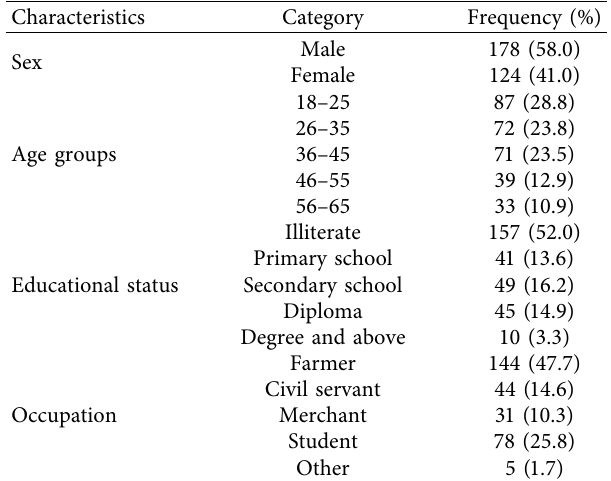
Table 1: Major demographic characteristics of the respondents from Gesha town,